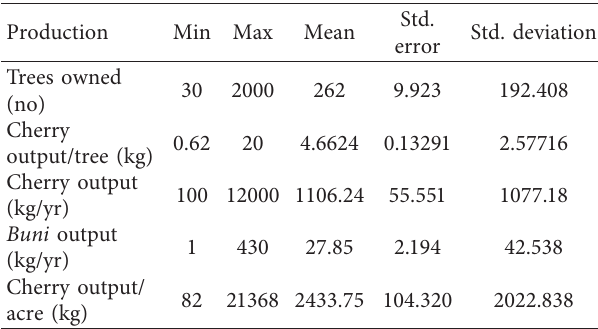
Table 5: Descriptive statistics for coffee production in the study area.